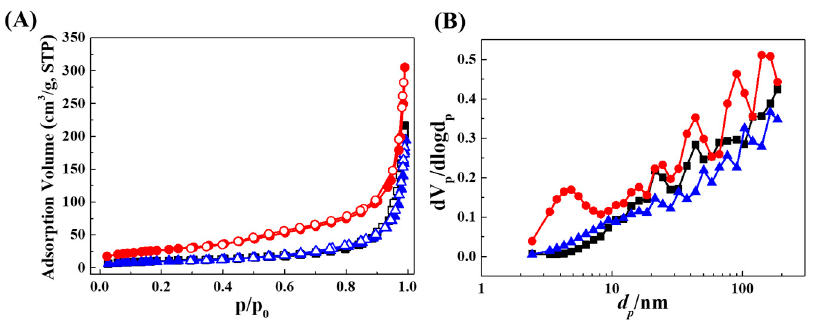
Figure 2. ( A ) N 2 adsorption–desorption isotherms and ( B ) corresponding Barrett-Joyner-Halenda (BJH) pore size distribution for Ag@LDO400 (black), Ag@LDO500 (blue), and Ag@LDO600 (red). Solid and open symbols in isotherms represented adsorption and desorption branch, respectively.